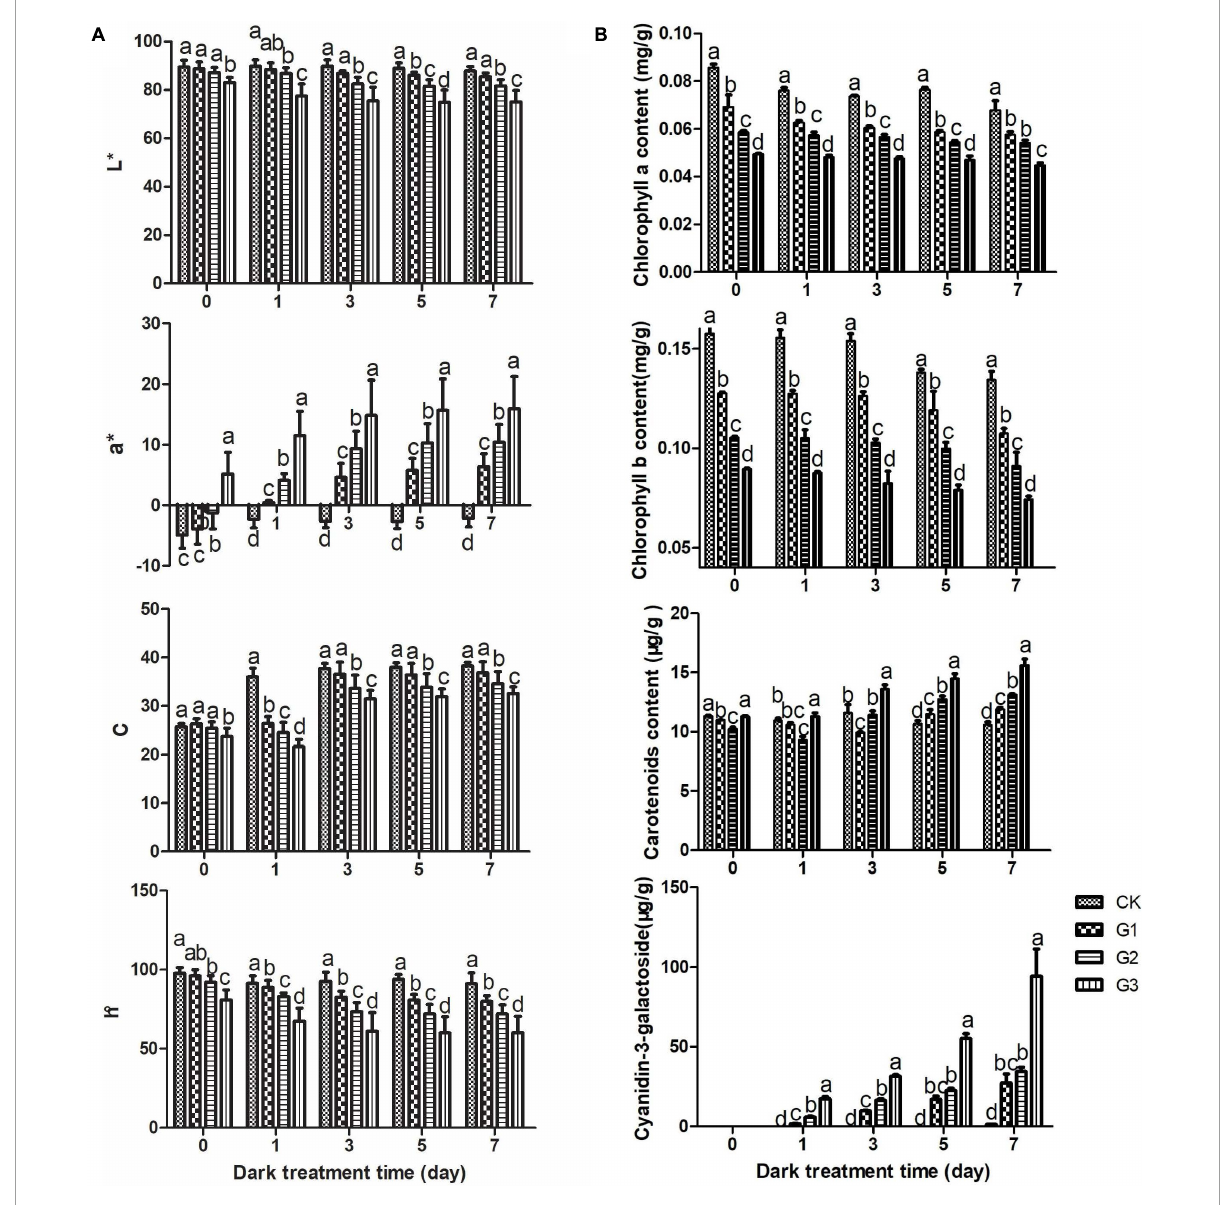
FIGURE2 Changes in apple peel color during dark treatment. Changes in apple peel color difference values (A) and the pigment content (B) during dark treatment. L* indicates brightness. Positive a* values indicate the darkness of the red coloration and are shown in red. Negative a* values indicate the darkness of the green coloration and are shown in green. C indicates the strength of the color, and h indicates the comprehensive